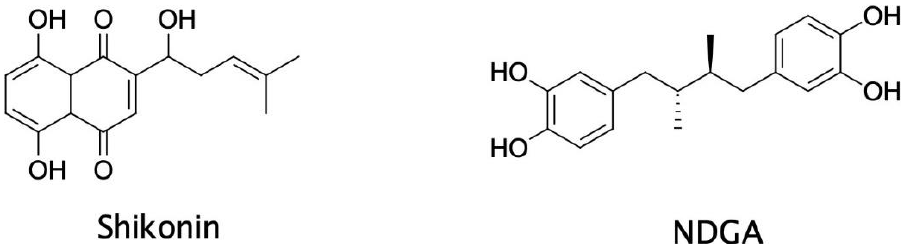
Figure 8. Chemical structures of the phytochemicals shikonin and NDGA.